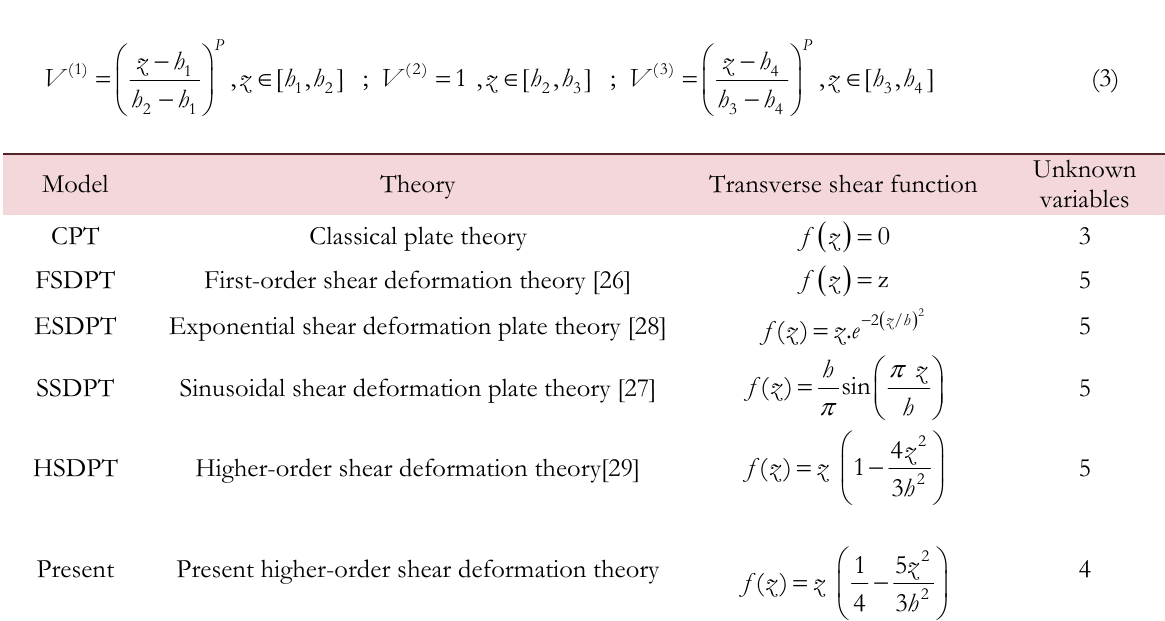
Table 1: Displacement